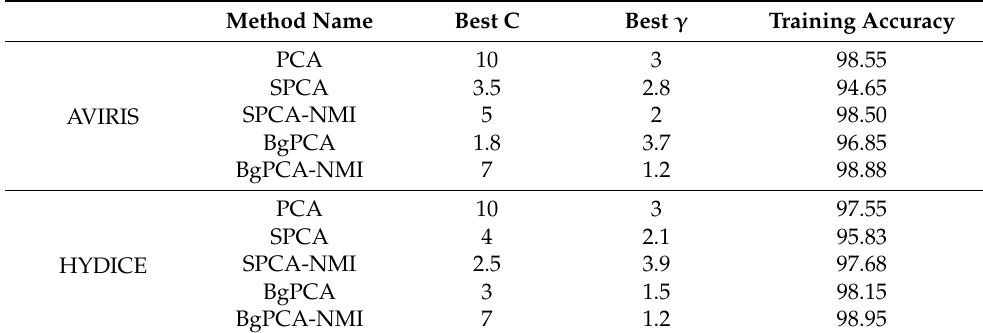
Table 4. Parameter tuning using 10-fold